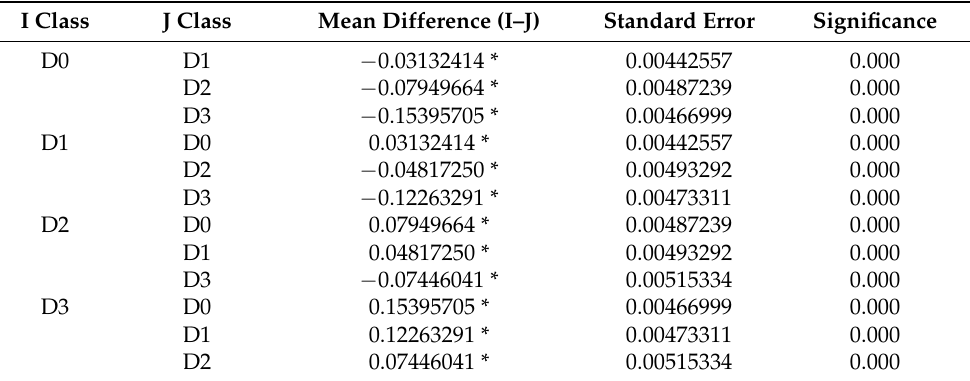
Table A6. Statistical Tukey’s HSD test for the key wavelength of 823 nm for the four excess nitrogen treatments: D0, D1, D2 and D3.